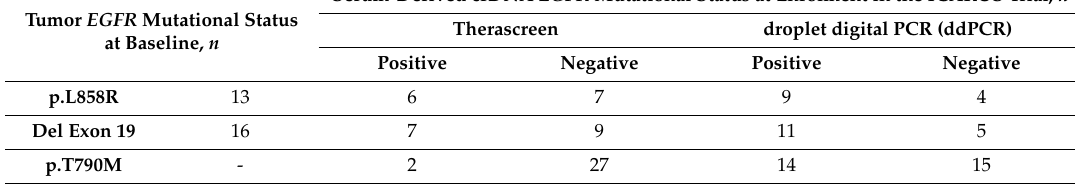
Table 2. Epidermal growth factor receptor ( EGFR ) mutations in serum-derived circulating cell-free DNA (cfDNA) samples obtained from non-small-cell lung cancer (NSCLC) patients enrolled in the ICARUS